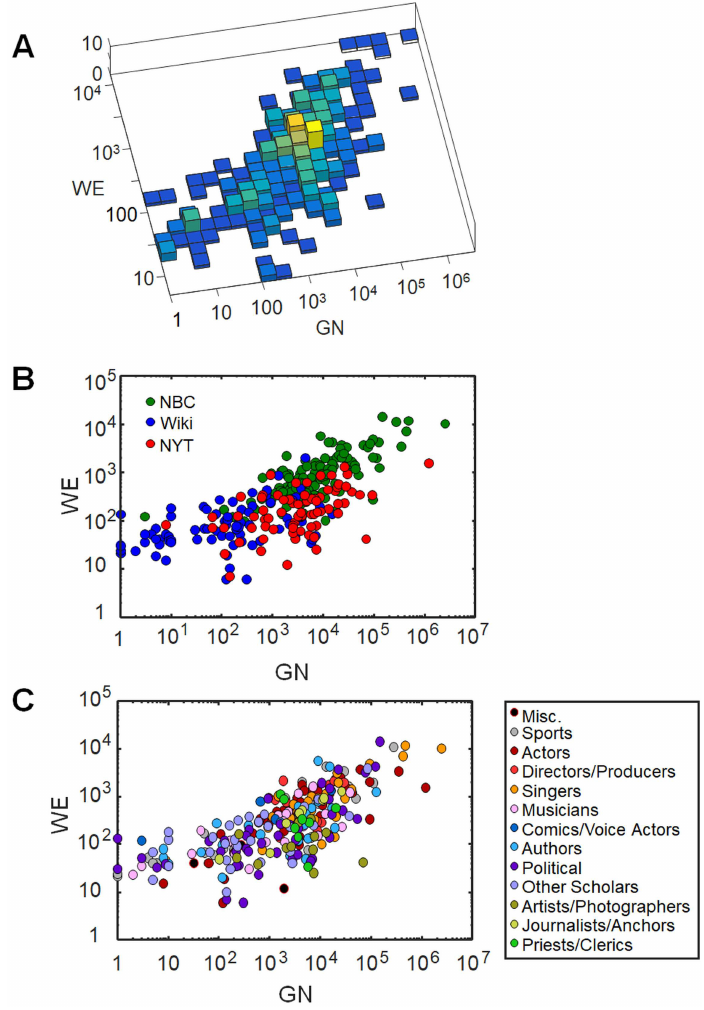
Fig 4. The correlation between GN and WE . The correlation between GN and WE , as measures of fame for the individuals in the three datasets (NBC, Wiki and NYT 1), is shown in three double-logarithmic plots. (A) The logarithms of GN and WE are reasonably well correlated, with a Pearson R = 0.71. (B) WE and GN show similar correlation in the three datasets, which sample different ranges of GN ; (C) WE and GN are shown with a color code that indicates the profession of the